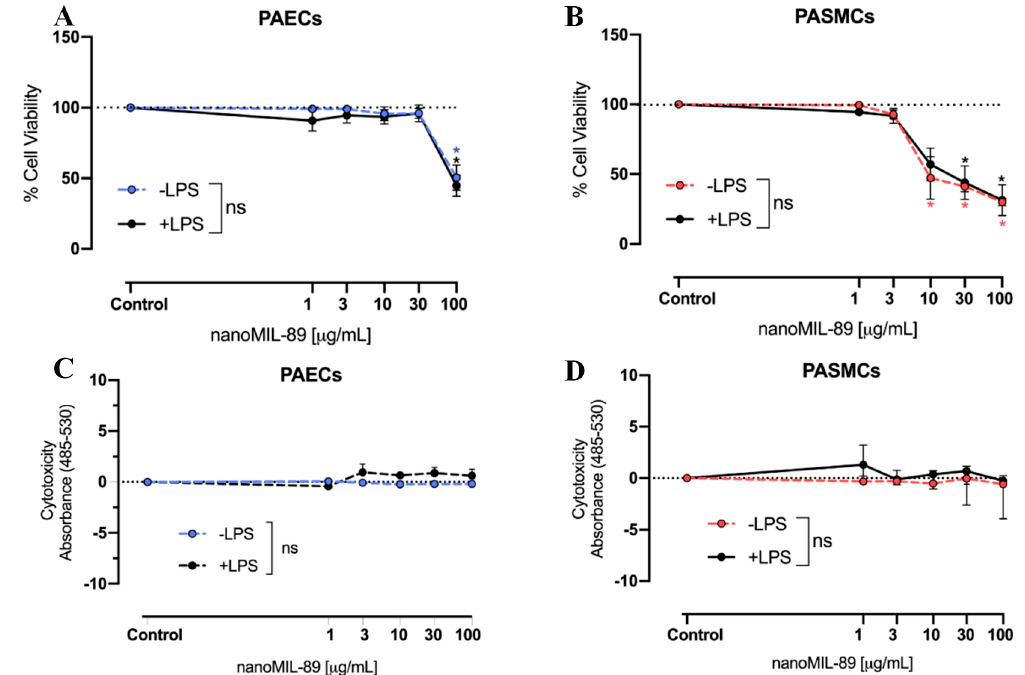
Figure 2. E ff ect of nanoMIL-89 on cell viability and toxicity. Cells were incubated in ( − LPS /+ LPS) culture media and treated with nanoMIL-89 (0, 1, 3, 10, 30,100 µ g / ml). ( A , B ) E ff ect of nanoMIL-89 on the viability of PAECs and PASMCs. ( C , D ) Toxicity e ff ect of nanoMIL-89 on PAECs and PASMCs. Data are mean ± SEM for n = 3. Statistical analysis between di ff erent groups ( − LPS /+ LPS) was determined by two-way Analysis Of Variance (ANOVA) followed by Bonferroni posttests (* p < 0.05). Statistical analysis for each condition compared to the relevant controls was determined by one-way ANOVA, followed by Dunnett’s multiple comparison post-test (* p < 0.05).